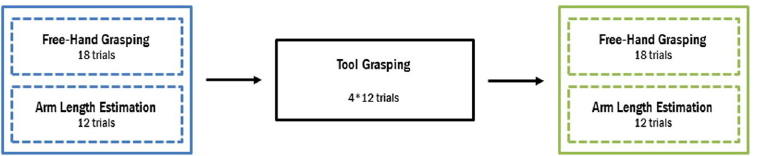
Figure 2. Experiment 1 timeline. Tool use session included 4 * 12 trials. Pre and post tool use sessions consisted of 18 free hand grasping movements and 12 arm length estimation trials. The two tasks were run by blocks and the order of the blocks was counterbalanced across